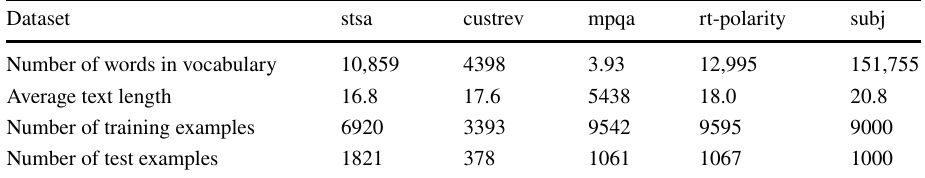
Table 6 Summary of datasets used in concept categorization task